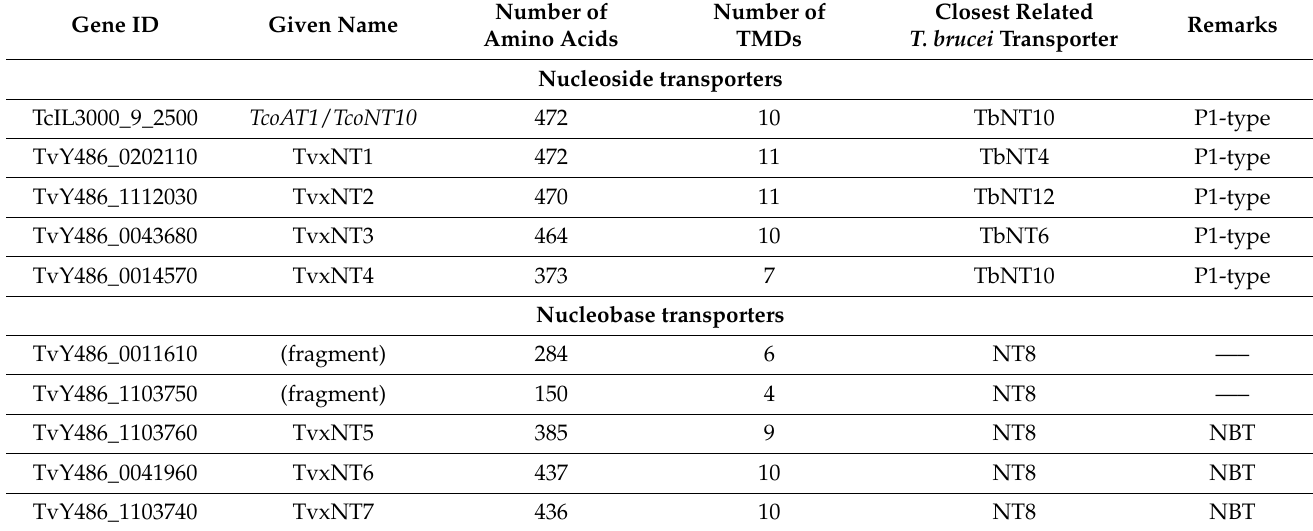
Table 2. ENT family genes of T. vivax .